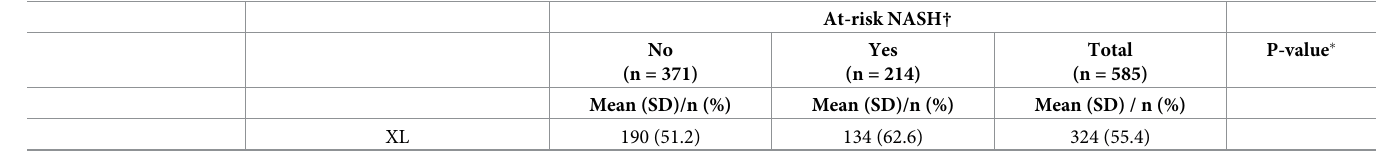
† At-risk NASH = Definite NASH on biopsy with a NAFLD Activity Score (NAS) � 4 with at least 1 point in each category and fibrosis stage � 2. � Based on chi-square test for categorical data and unequal variance t-test for continuous data. �� LSM: Liver stiffness measurement; CAP: controlled attenuation parameter.